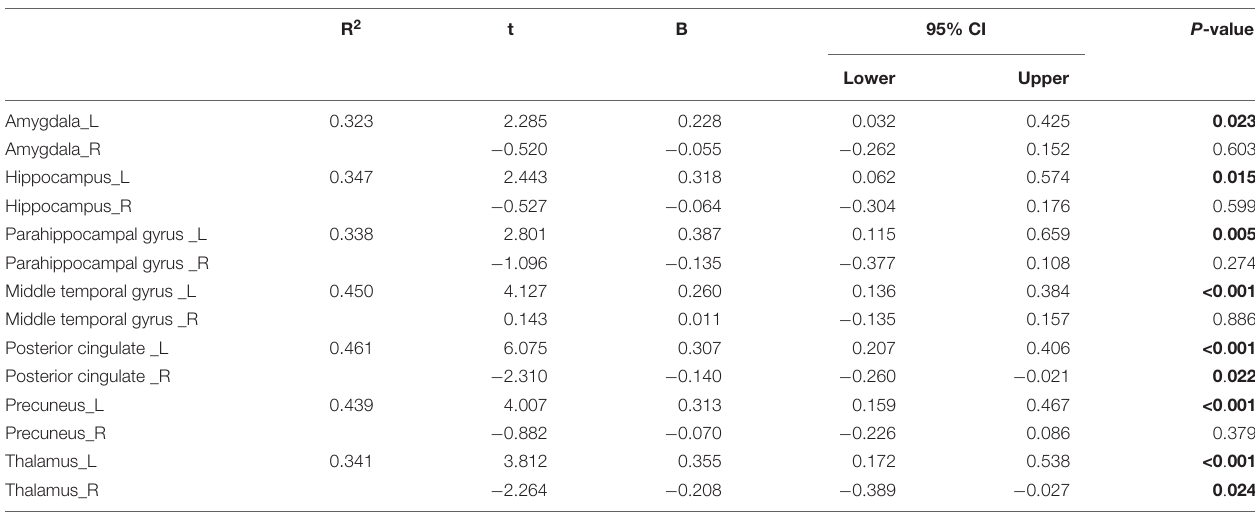
TABLE 3 | Associations of CBF with cognition